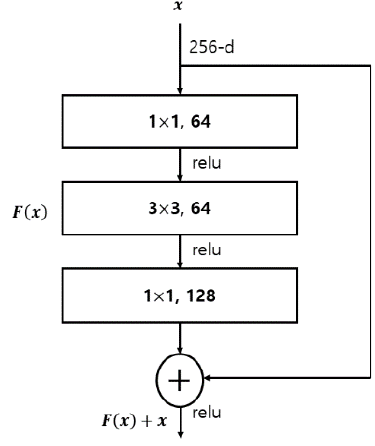
Figure 14. Residual Connection.